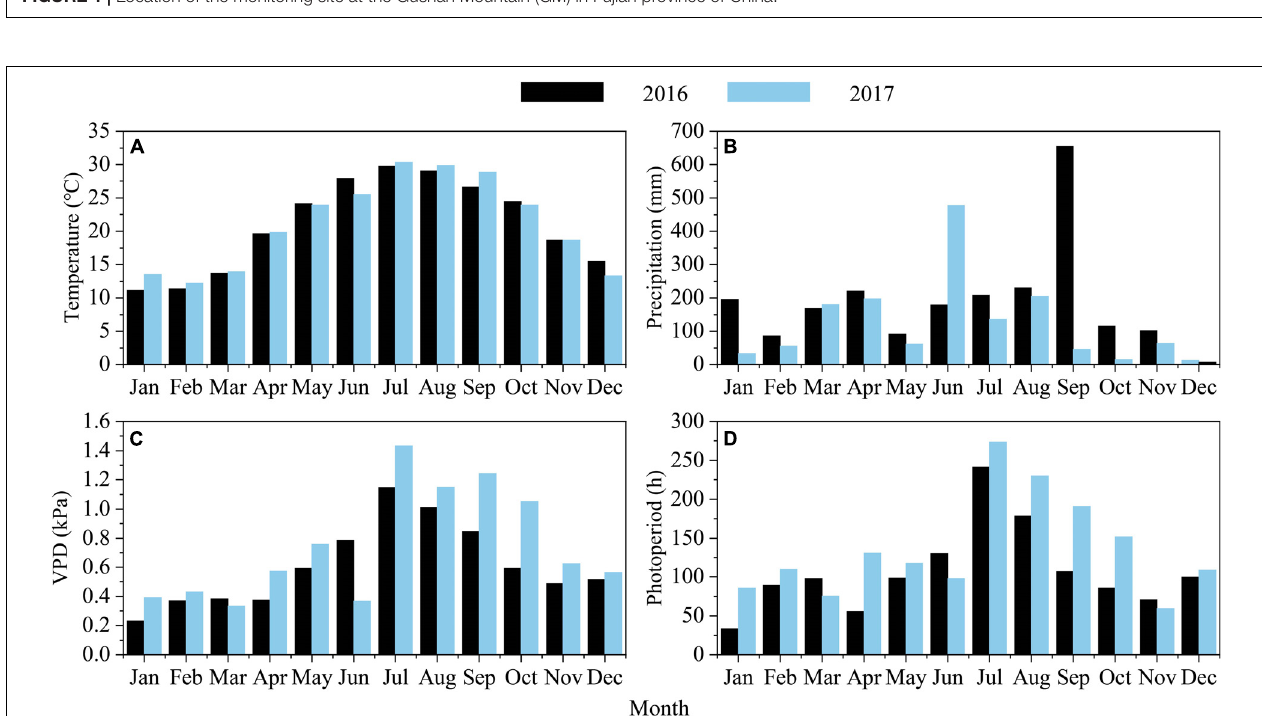
FIGURE 2 | (A) Mean air temperature and (B) precipitation and (C) vapor pressure deficit (VPD) and (D) sunshine duration during 2016 and 2017 in Fuzhou city (10 km away from the site location).